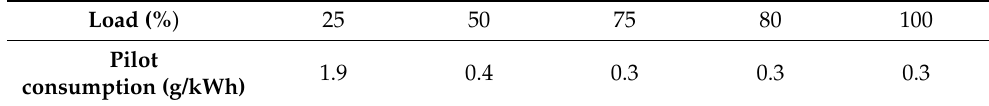
Table 3. Pilot consumption in gas